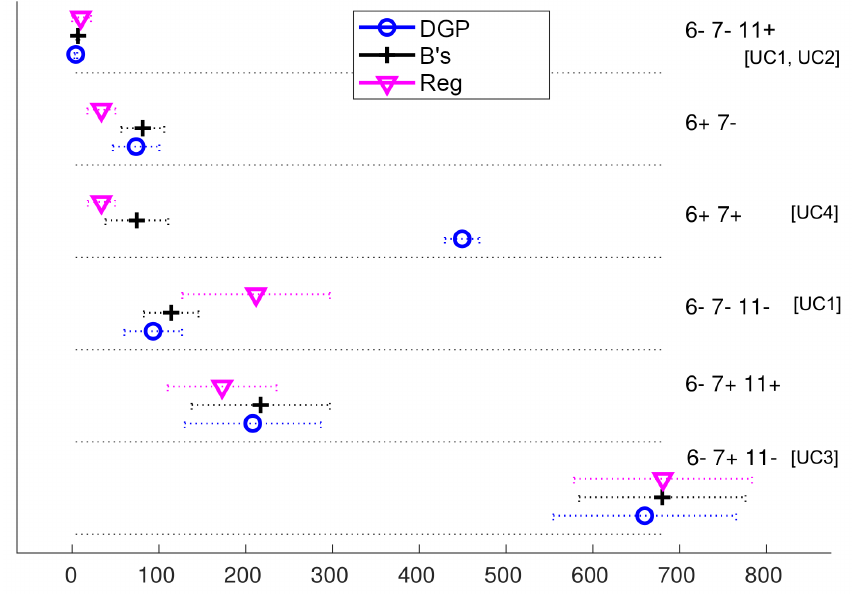
Figure A1. On the right side, from top to bottom, the six distinctive behaviours—clusters of scenarios— found for the M 1 ( α R − entry ) measure, arranged in six rows. The abscissa is the magnitude of that measure (number of iterations of the methods before entering steady-state). Each method within a behaviour has a point marker with its average value in the measure and ± 1 σ intervals around it (only illustrative of the dispersion, due to skewness). The lower values, the better. The behaviours are labelled with the sets of scenarios that produce them (axes at their minimum extreme ( − ) or at their maximum (+) in all scenarios of the cluster). In square brackets, we also indicate the practical use cases that match the behaviours, from the ones described in Section 3.4.